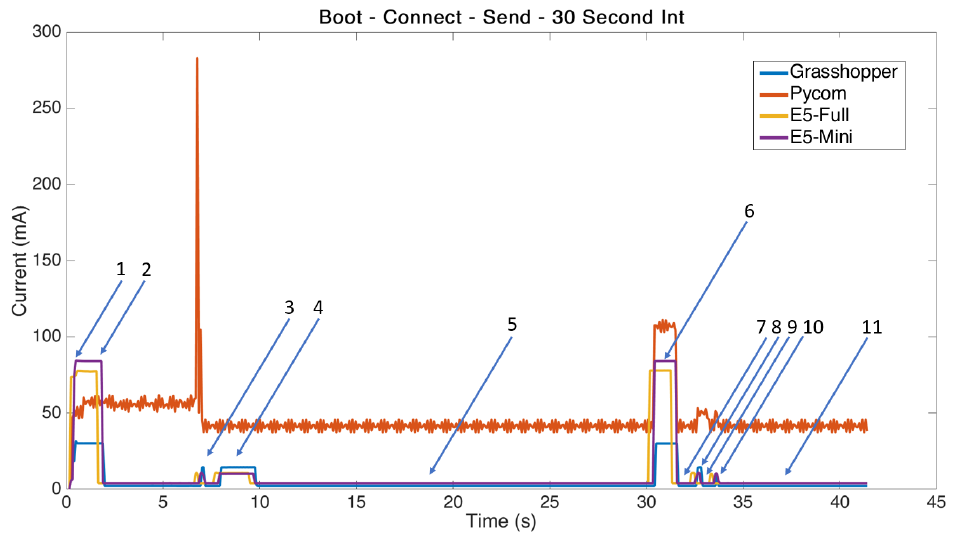
Figure 1. Power consumption for different prototyping boards. (state descriptions in Table